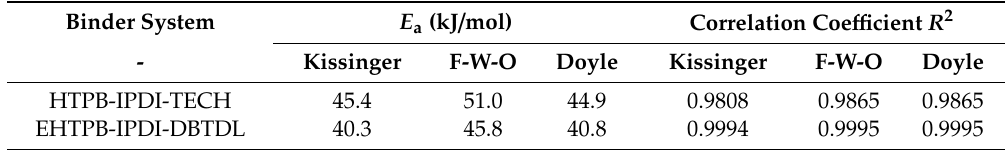
Table 5. E a and R 2 of the curing reaction calculated by Kissinger, F-W-O and Crane equation. Binder System E a (kJ / mol) Correlation Coe ffi cient R